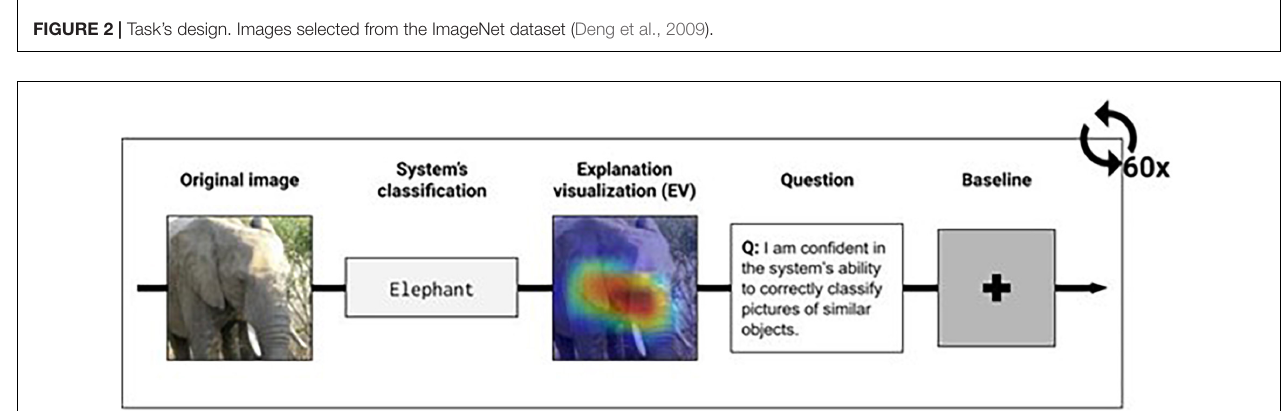
FIGURE 3 | Task design. Images selected from the ImageNet